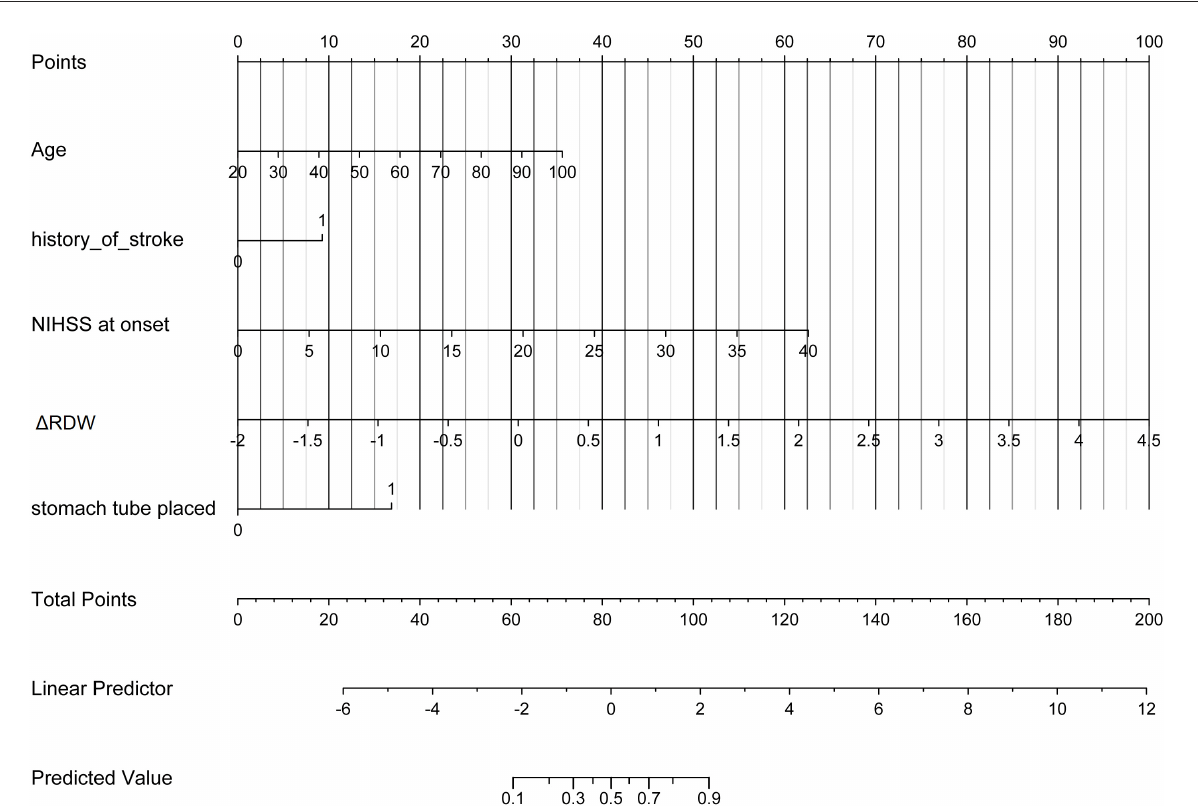
FIGURE3 Developed poor neurological outcomes recovery nomogram. With the age, the history of stroke, NIHSS score at onset, 1 RDW, and indwelling gastric tubes in the cohort, a poor neurological outcomes recovery nomogram was developed. In our research, depending on the size of the regression coefficient, the nomogram scored the value of each variable. By converting each patient’s score into a probability, the probability of different outcomes for each patient could be calculated. 1 RDW, the third day after IVT red blood cell distribution width – on admission red blood cell distribution